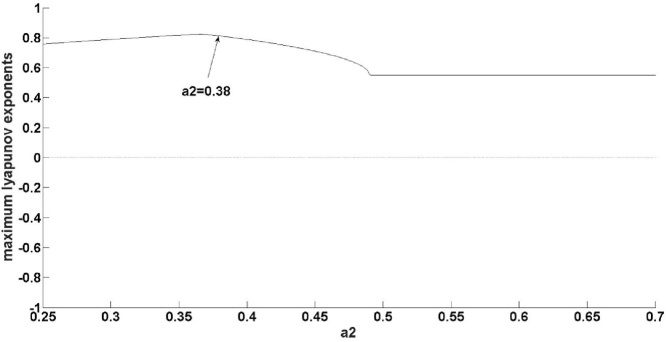
Maximum Lyapunov at situation 1.